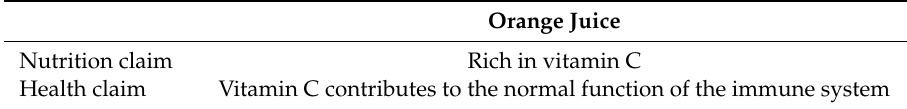
Table 1. Nutrition and health claims used in the study.